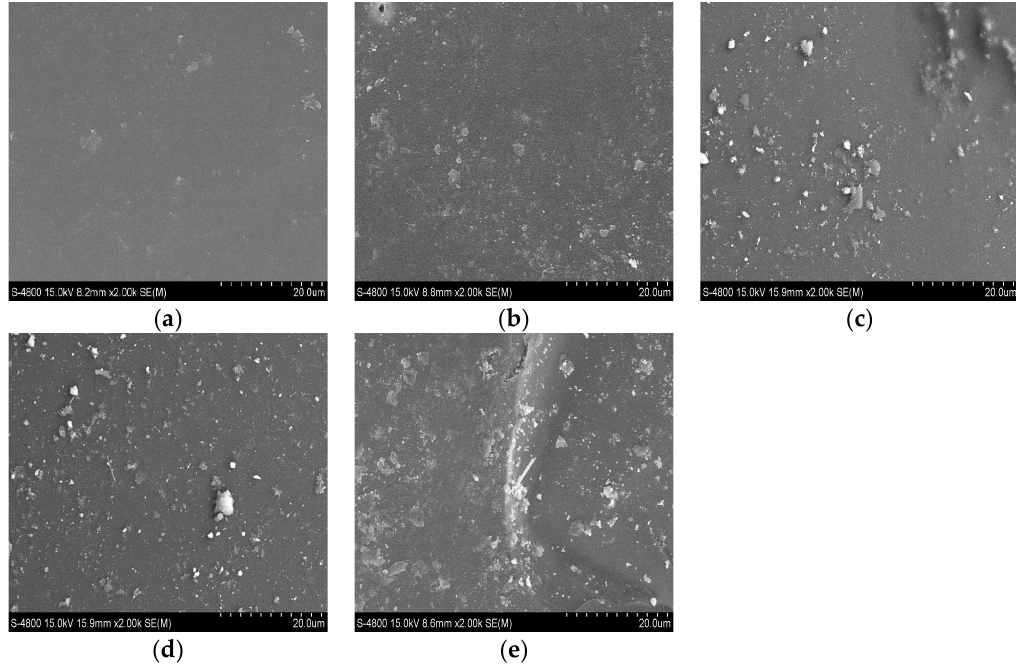
Figure 7. Micromorphology analysis of slag beads under different basicities. ( a ) R = 0.8; ( b ) R = 0.9; ( c ) R = 1.0; ( d ) R = 1.1; ( e ) R = 1.2.